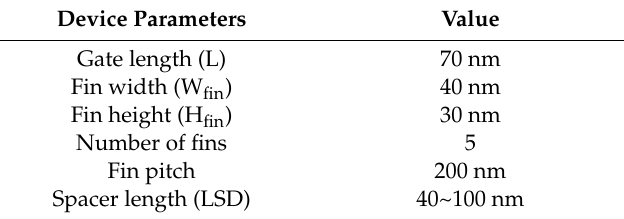
Figure 1. ( a ) Top-view SEM image of the bulk FinFET; and ( b ) definition of fin height, fin width, channel length, and pitch in FinFETs. Table 1. Device structure parameters of FinFETs.